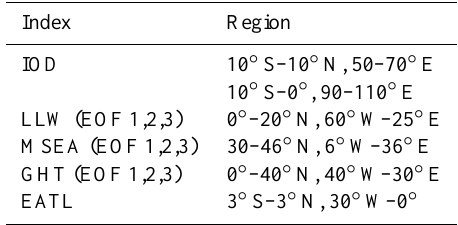
Table 2. Regions for generated indices.